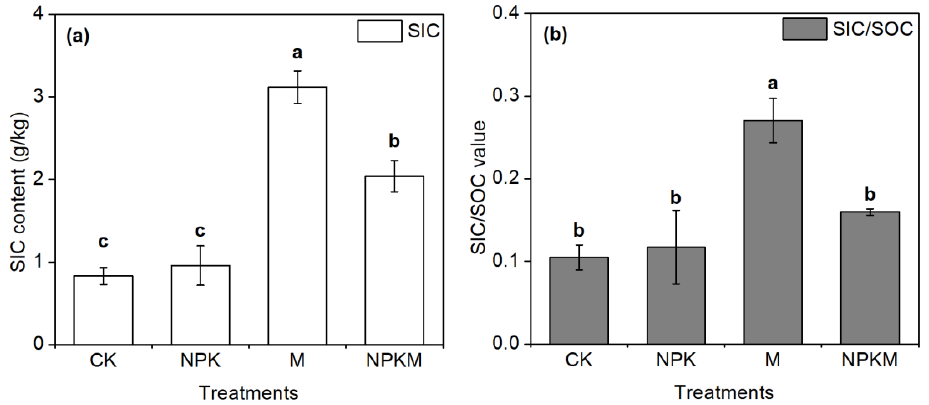
Figure 2. Soil carbon content under different long-term fertilization: ( a ) SIC content; ( b ) value of SIC/SOC. Error bars represent the standard deviations of the mean ( n = 3). Different characters above bars indicate significant differences among the treatments at p < 0.05.